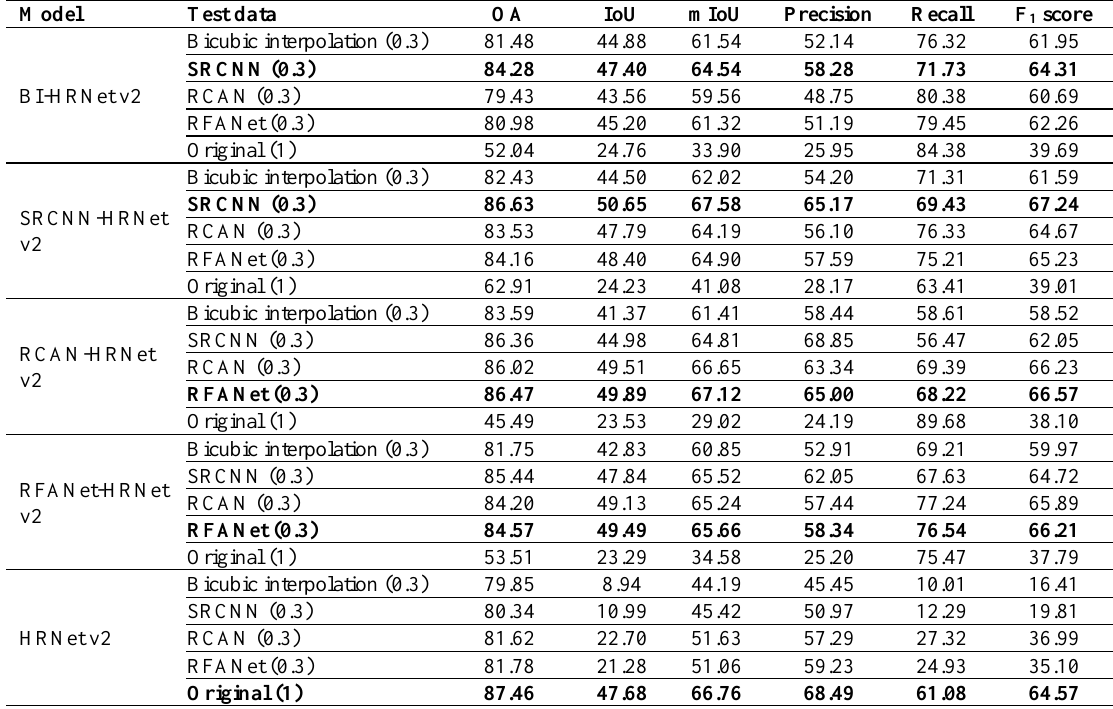
Table 2. Quantitative evaluation of building footprint extraction results (in %)